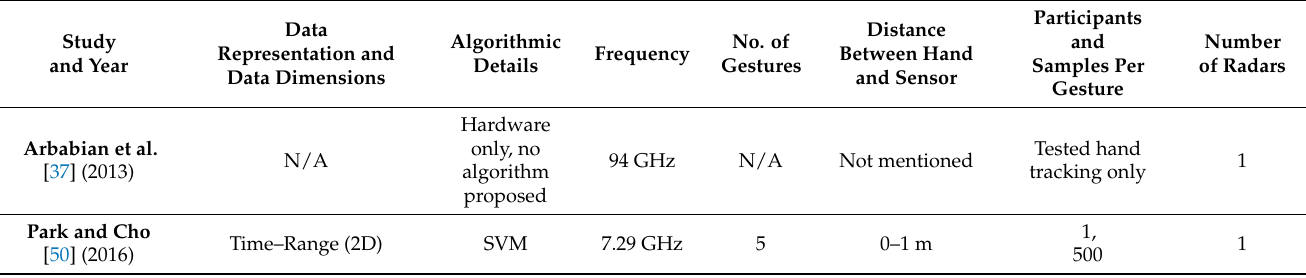
Table 3. Summary of HGR algorithms for Pulsed